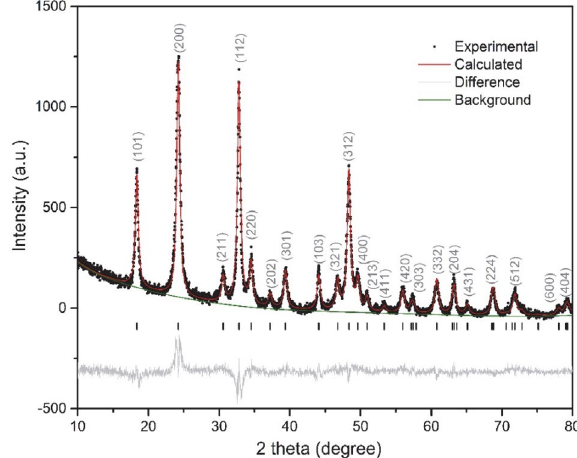
Fig. 2. X-ray powder diffraction pattern of the NdVO 4 nanopowder. The black full circles represent raw data and, red solid line is the Rietveld fit, the black vertical bars are the Bragg reflections, while the grey line shown below is the difference between observed and calculated intensity.